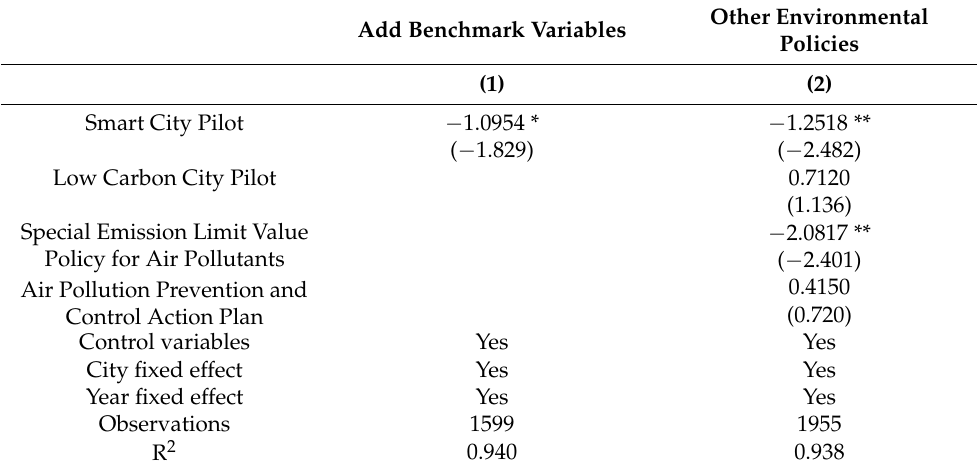
Table 3. Regression results for the self-selection problem and considering other